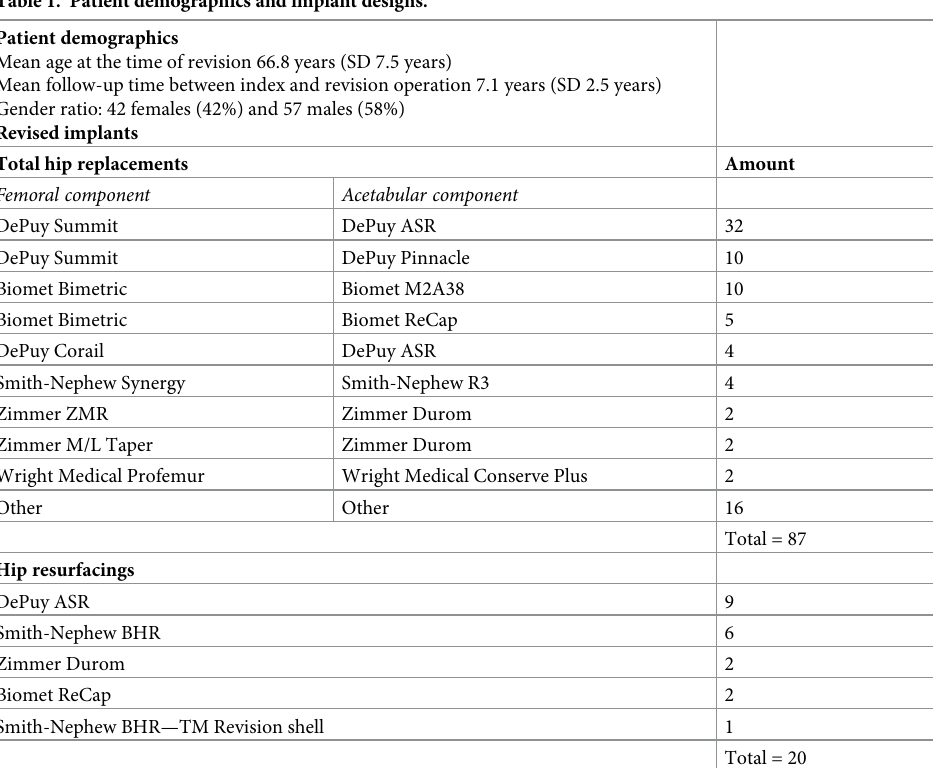
Table 1. Patient demographics and implant